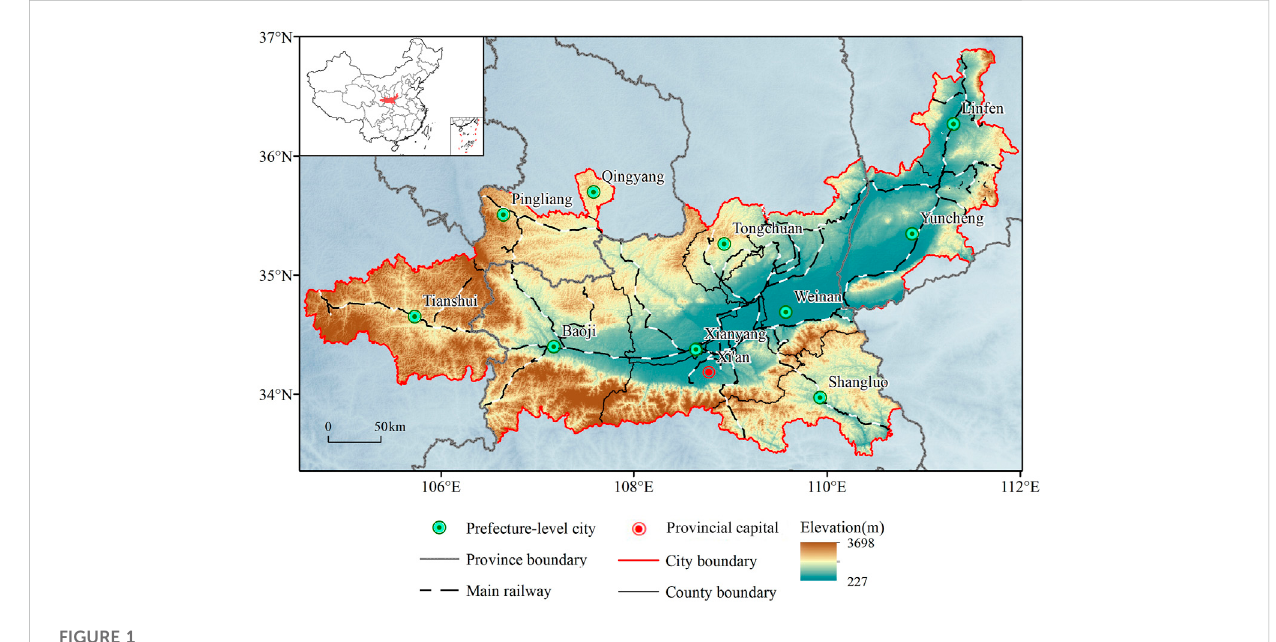
FIGURE 1 Overview of the study area.